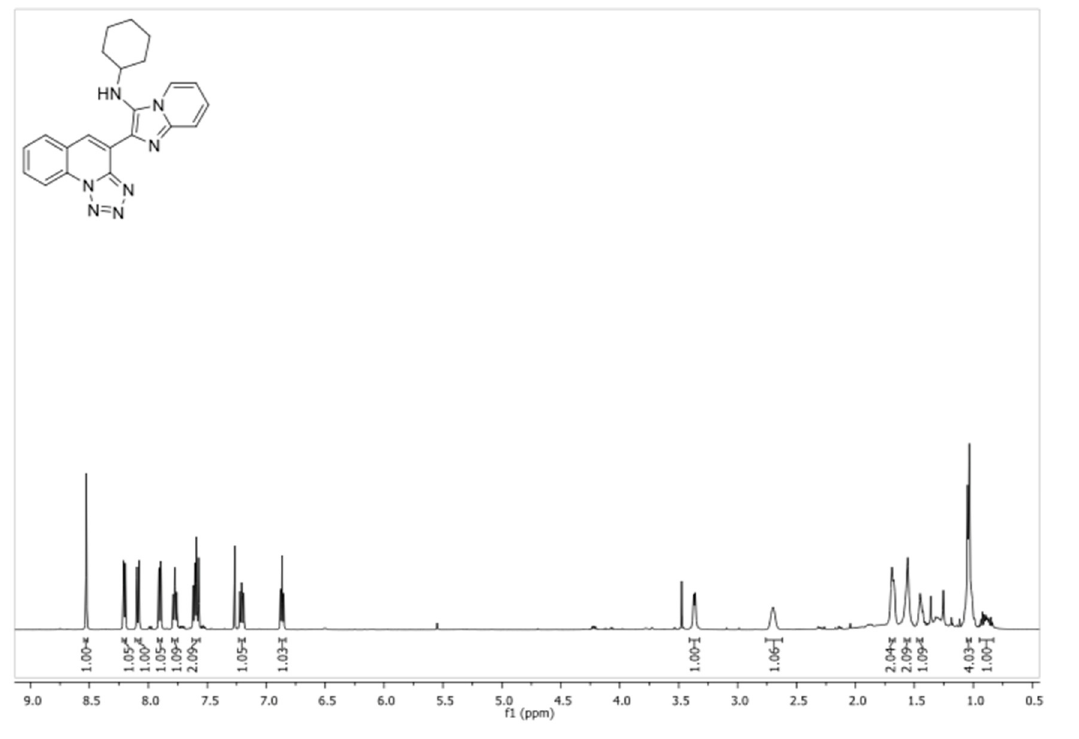
Figure 1. 1 H NMR spectrum of compound 5a .